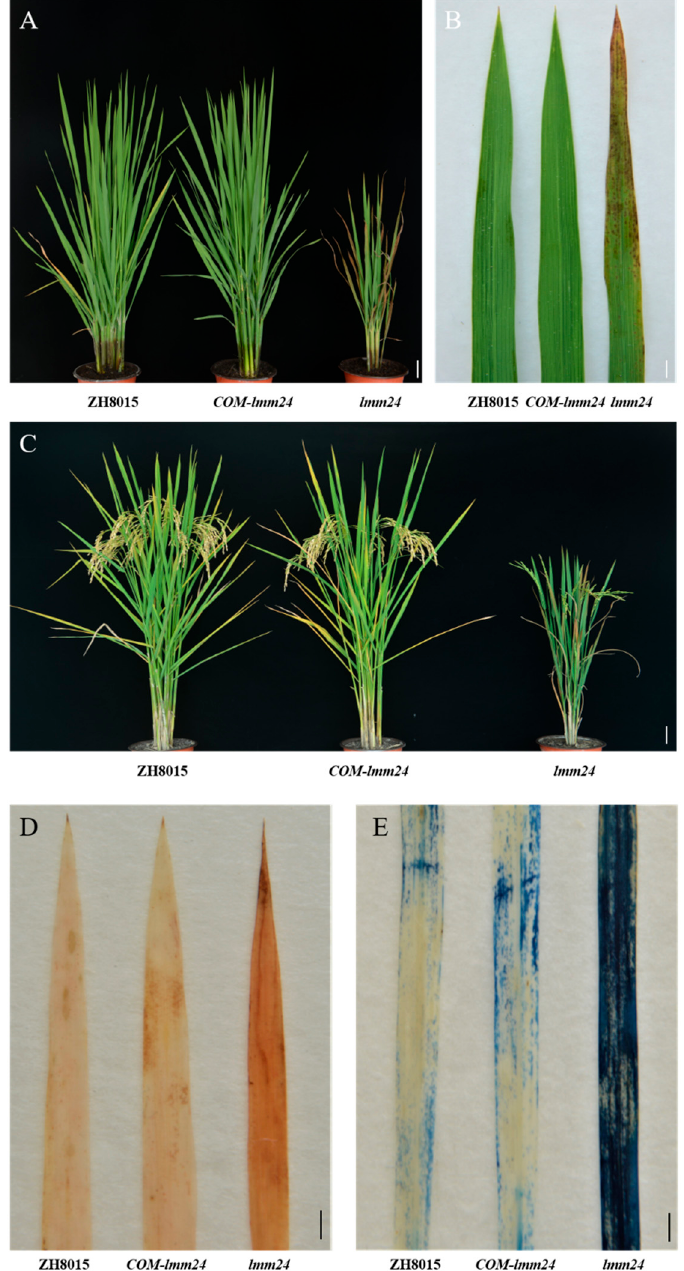
Figure 6. Genetic complementation of LMM24 . ( A ) lmm24 plant transformed with the genomic sequence of ZH8015 ( COM-lmm24 ) was completely recovered to the ZH8015 phenotype at tillering stage. ( B ) Leaves phenotype of ZH8015, transgenic plant and lmm24 . ( C ) The phenotype of ZH8015, transgenic plant and lmm24 at harvest period. ( D ) DAB staining experiment. ( E ) Evans blue staining analysis. Scale bar: 10 cm in ( A , C ), 2 cm in ( B ),1 cm in ( D , E ). 2.7. LMM24 Encodes Receptor-Like Cytoplasmic Kinase 109 in Rice As annotated on RGAP (http://rice.plantbiology.msu.edu), LOC_Os03g24930 ( LMM24 ) is composed of four exons and three introns, a genomic DNA (gDNA) sequence of 2185 bp, a coding sequence of 1344 nucleotides, and encodes a putative 448 amino acid protein with a tyrosine protein kinase domain. Previous research showed that LMM24 encodes receptor-like cytoplasmic kinase 109 (OsRLCK109) [18]. RLCKs in plants belong to the super family of receptor-like kinases (RLKs), which lack extracellular ligand-binding domains. The predicted protein scheme for OsRLCK109 shows a